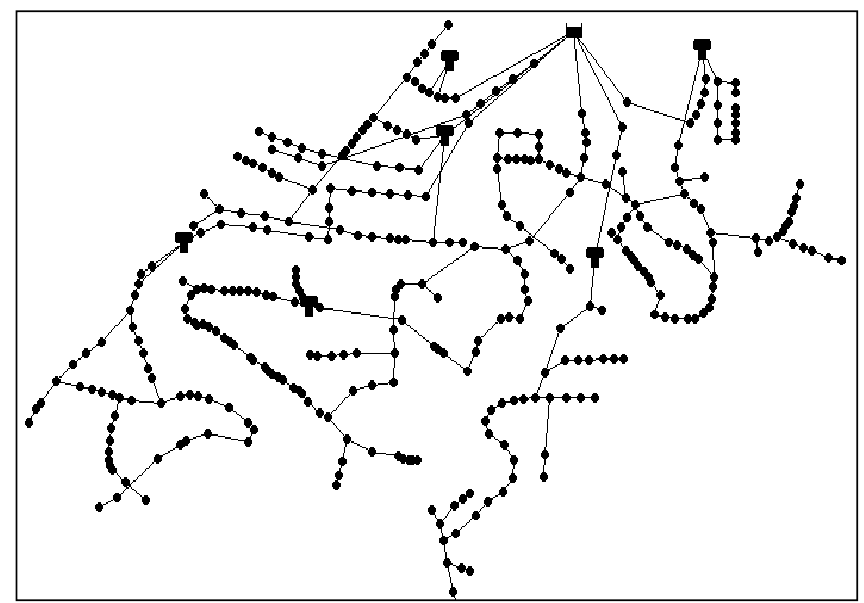
Figure 1. Graphical representation of the Fraccionamiento Real Montecasino (FRM) hydraulic network [35].